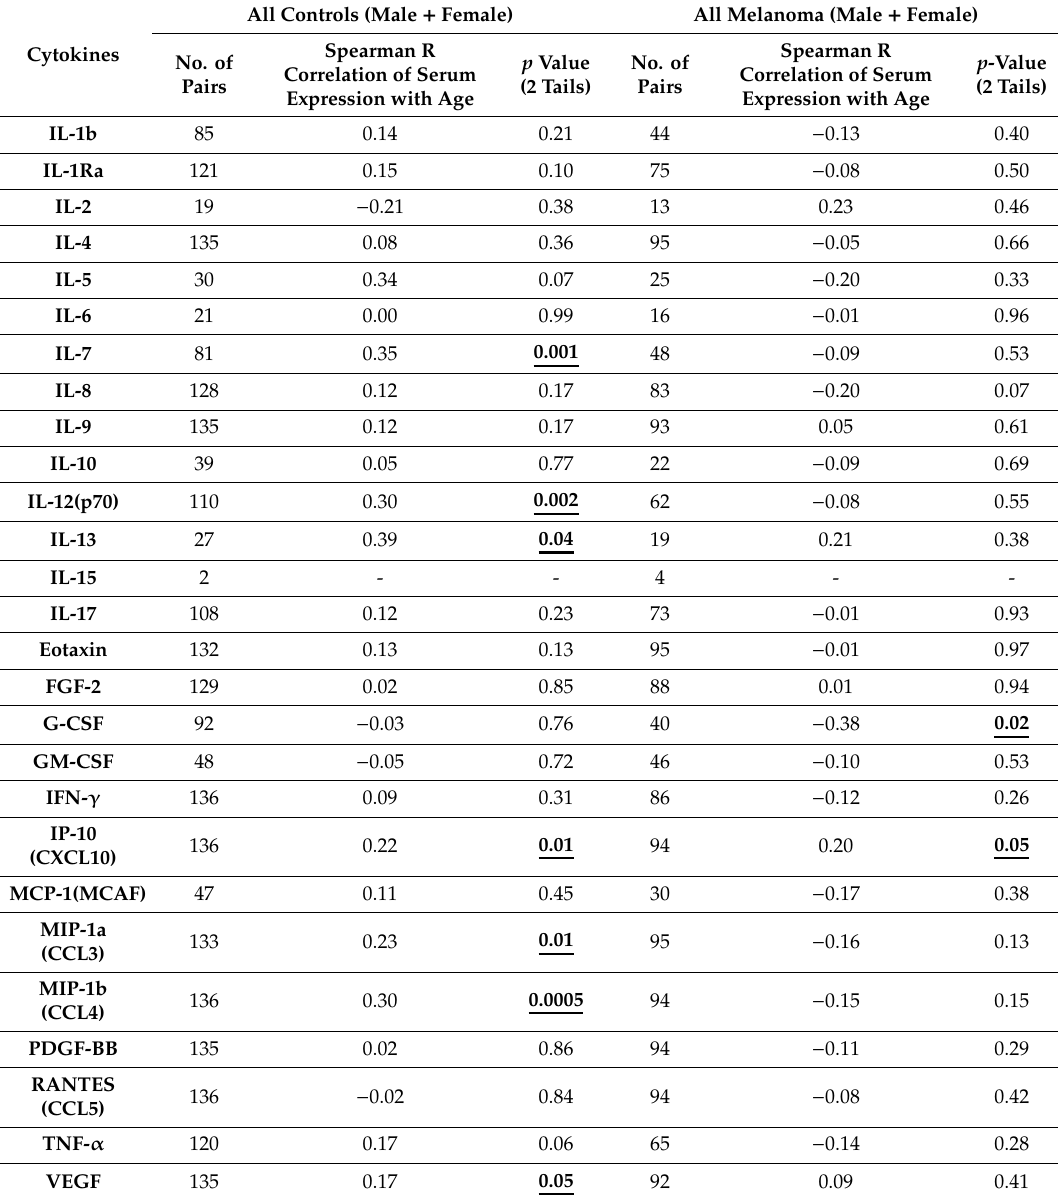
Table 5. Serum expression in all melanoma patients (male + female): correlation with age. For p -values < 0.05 (reported in bold and underlined), the null hypothesis (i.e., the Spearman correlation coe ffi cient R is 0) should be rejected; i.e., cytokine distributions with p -values < 0.05 are significantly correlated with